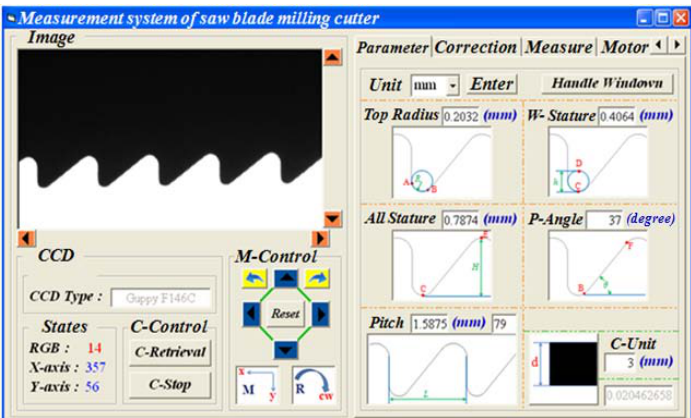
Figure 12. “Structure of measurement system”.